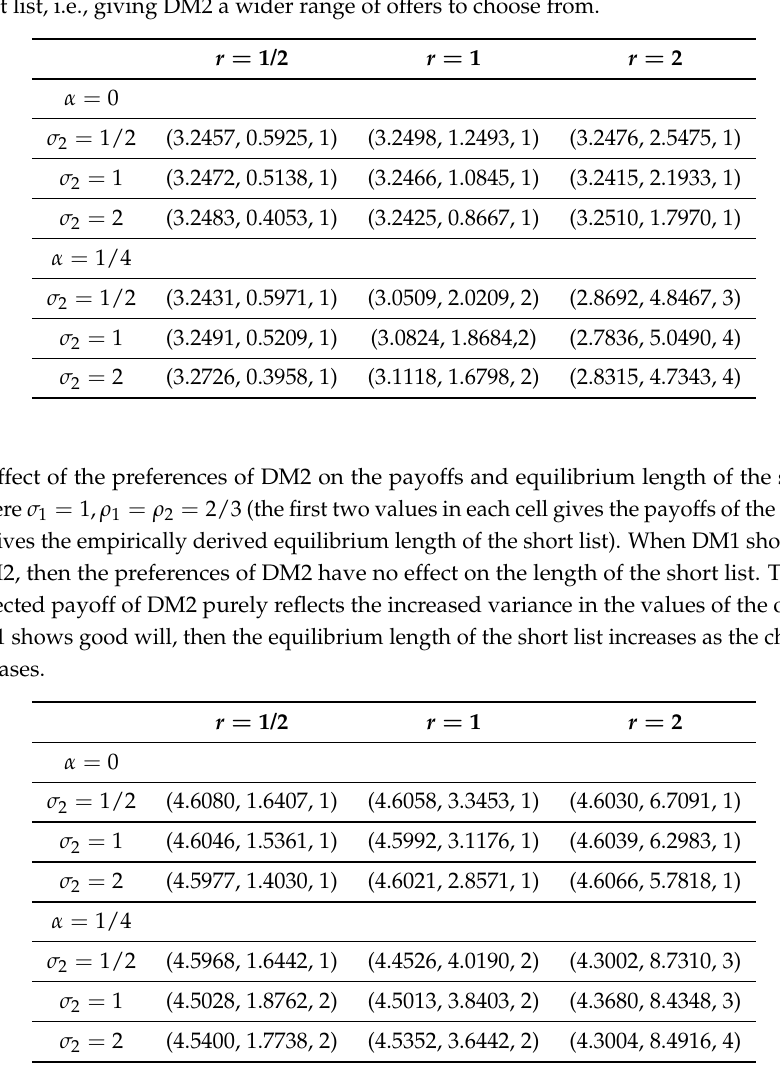
Table 5. Effect of the preferences of DM2 on the payoffs and equilibrium length of the short list in games where σ 1 = 1, ρ 1 = ρ 2 = 1/3 (the first two values in each cell gives the payoffs of the players and the third gives the empirically derived equilibrium length of the short list). As the level of good will shown by DM1 increases, he is increasing willing to accept a decrease in his own expected payoff, in order to ensure an increase in the expected payoff of DM2. This is obtained by increasing the length of the short list, i.e., giving DM2 a wider range of offers to choose from.